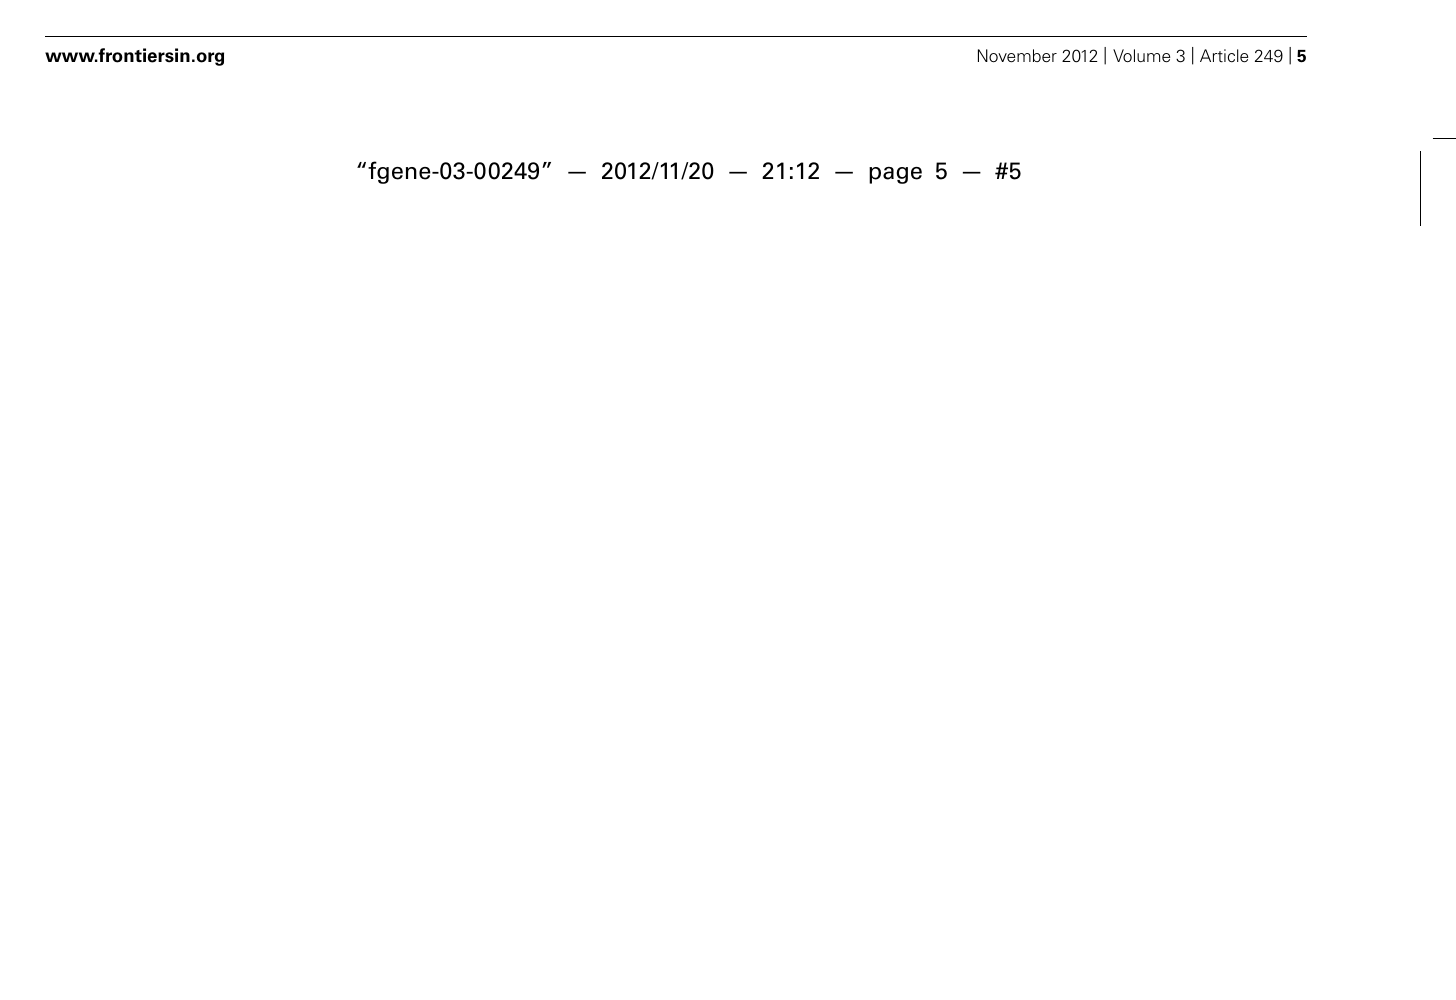
FIGURE 1 | 6-mercaptopurine (6-MP) intracellular pathways with polymorphisms suggested to increase the occurrence of adverse effects. SAM, S-adenosylmethionine; SAH, S-adenosylhomocysteine;TPMT, thiopurine S-methyltransferase; XO, xanthine oxidase; 6-Me-MP,